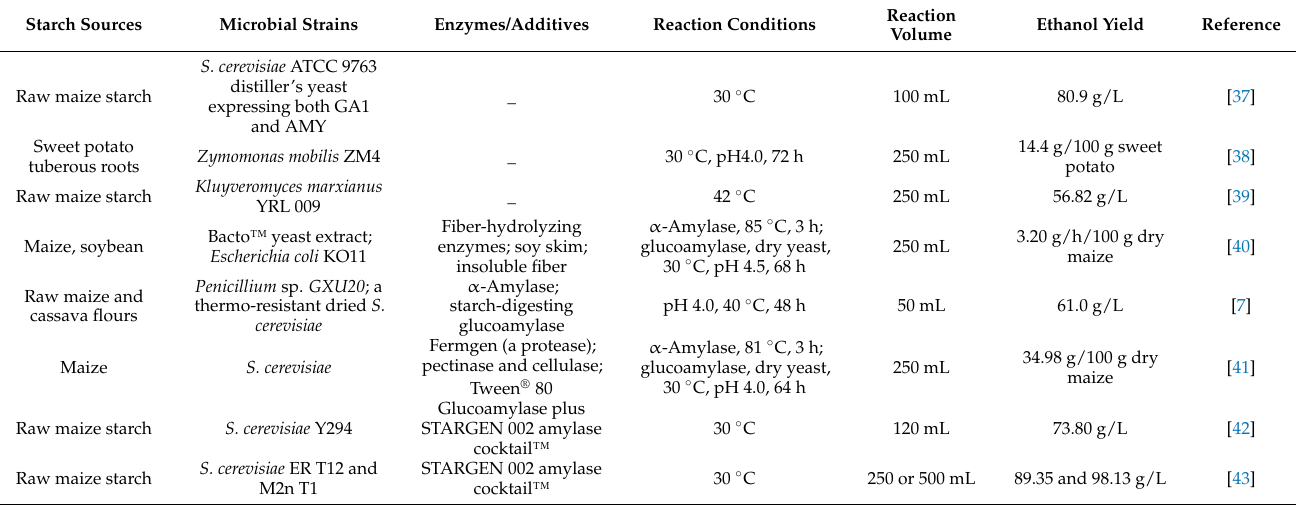
Table 1. Microbial strains, enzymes used in laboratory and industrial ethanol